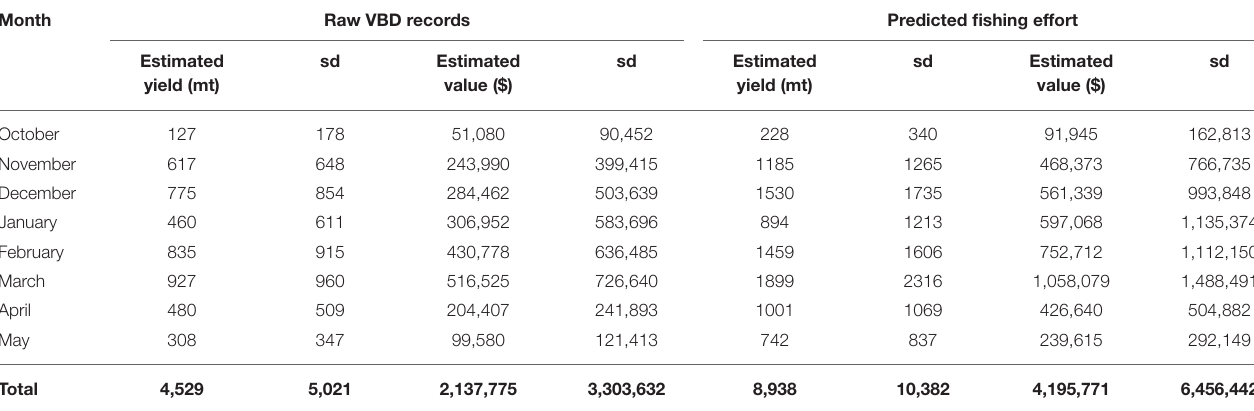
TABLE 5 | Estimates of the purse seine fishery total yield and value. Month